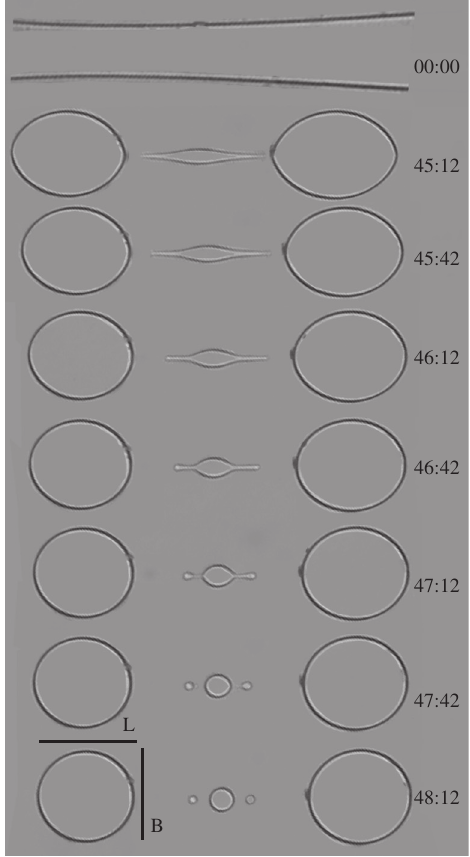
Figure 2. SAN filament break and droplet retraction in a PBT matrix after 45 minutes at 240 °C, where L and B are the semi-axis of the ellipsoid drop,